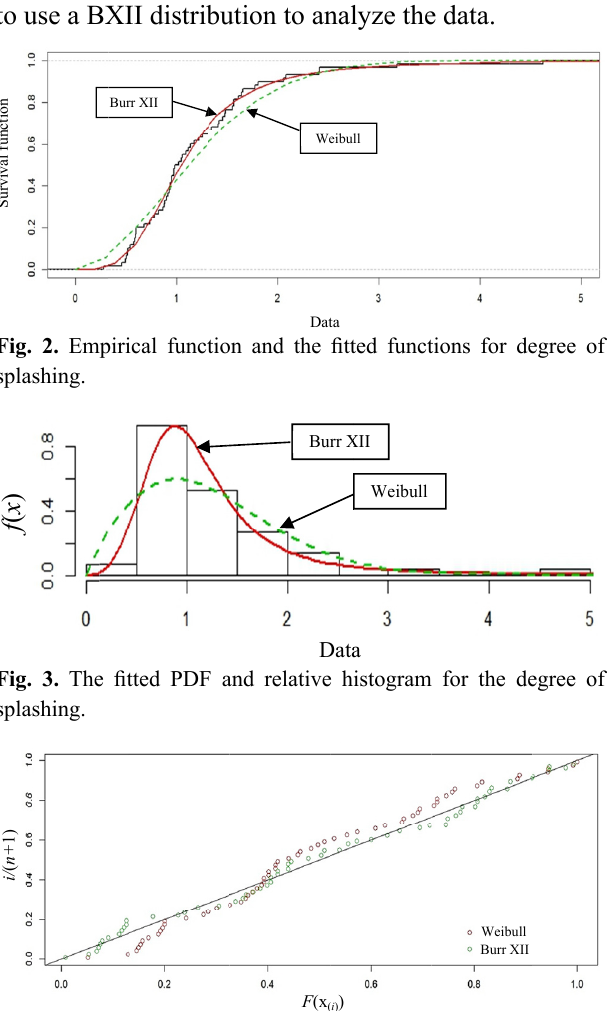
Fig. 4. The P-P plots for degree of